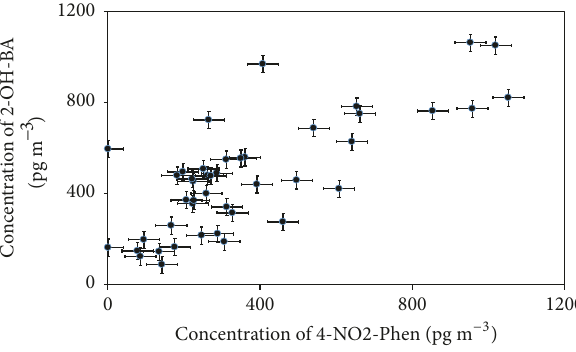
Figure 5: Scatter plot of 4-nitrophenol (4-NO2-Phen) concentra- tion versus 2-hydroxybenzoic acid (2-OH-BA) concentration. Error bars shown are the 3% reproducibility of CE